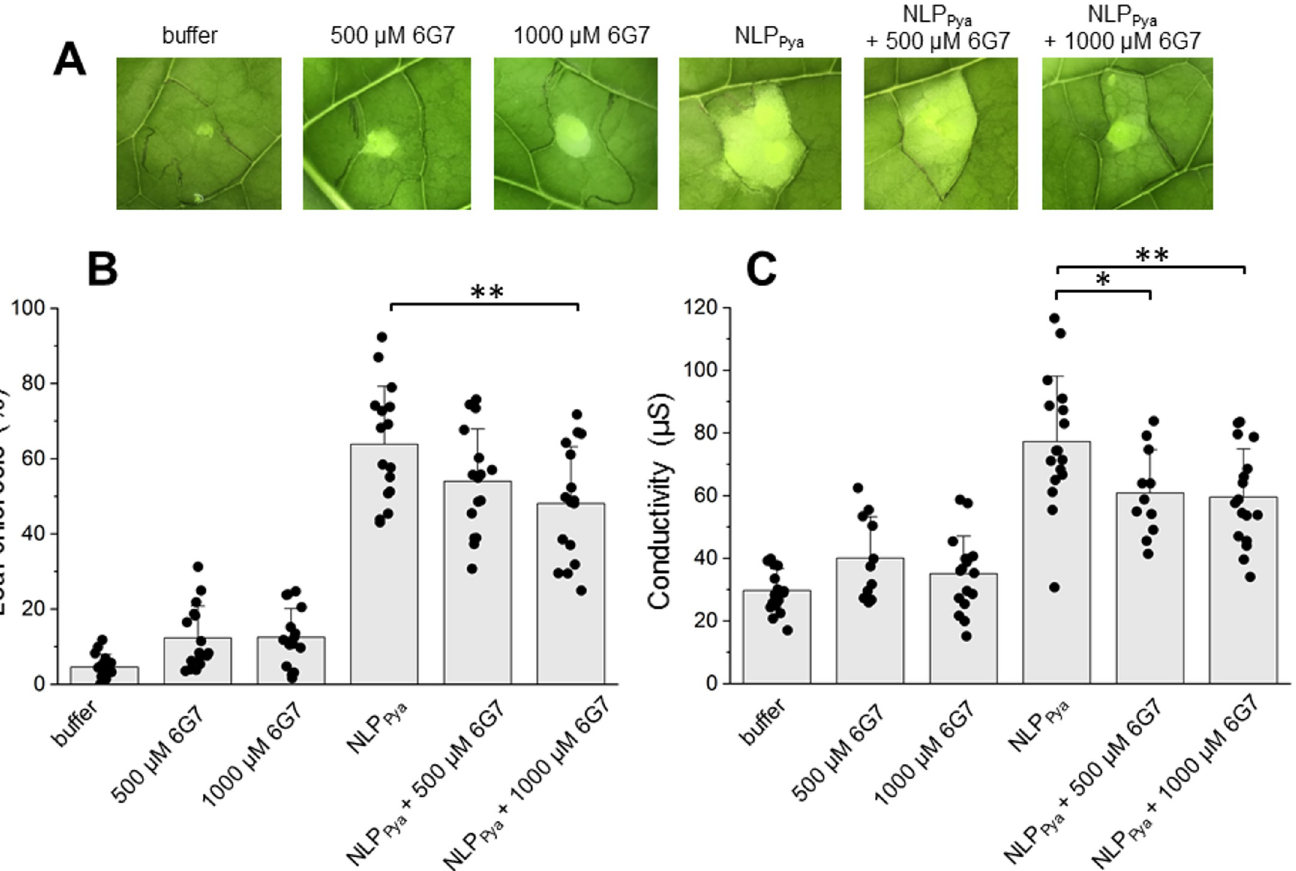
Fig 6. The inhibitory effect of the compound 6G7 on NLP toxicity. (A) The effects of 500 μ M and 1 mM 6G7 on necrotic lesions formation induced by infiltrating tobacco leaves with 100 nM NLP Pya . 6G7 and protein were dissolved in 20 mM MES, 150 mM NaCl, pH 5.8, containing 10% DMSO (buffer). The upper part of the leaf was photographed after 24 h. The injected solution of protein caused leaf necrosis, whereas buffer or the compounds alone did not substantially affect the plant tissue. (B) Statistical analysis of leaf chlorosis developed 24 hours after infiltrating tobacco leaves with either buffer, 6G7 or 100 nM NLP Pya in absence and presence of 6G7 . Values are means ± SD (n = 16), �� P < 0.01 vs. control (NLP Pya ); Student’s t-test. Buffer, 20 mM MES, 150 mM NaCl, pH 5.8, 10% DMSO. (C) Quantification of cell death by means of ion leakage experiment measurement. Values are means ± SD (n = 12–18), � P < 0.05, �� P < 0.01 vs. control (100 nM NLP Pya ); Student’s t-test. Buffer, 20 mM MES, 150 mM NaCl, pH 5.8, 10% DMSO.